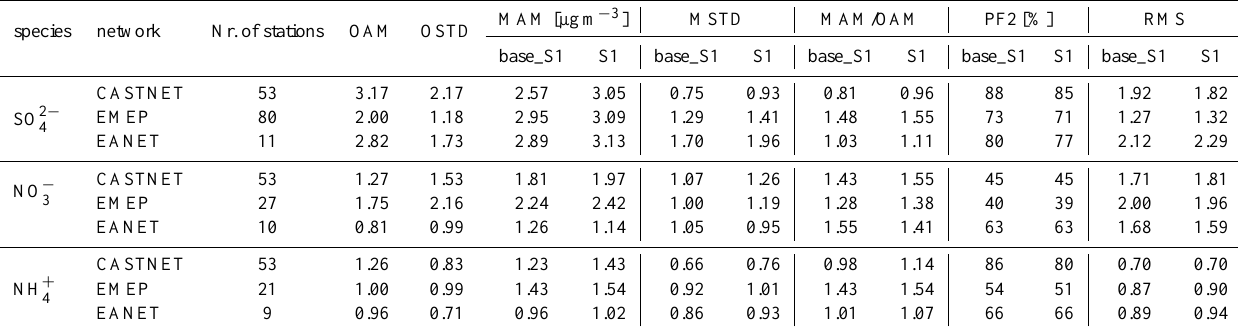
Table 5. Summary of the comparison of the base_S1 and S1 model simulations to observations of aerosol concentrations during January- March 2001. OAM and MAM are the arithmetic mean of the observations and of the model, respectively, in µgm − 3 , while OSTD and MSTD are the standard deviation of the observations and model, respectively, in µgm − 3 . MAM, OAM, MSTD and OSTD represent co- located measurements and model results (i.e., based on the locations of the observations). PF2 is the percentage of modelled point within a factor of two of the observations. RMS denotes the Root-Mean-Square